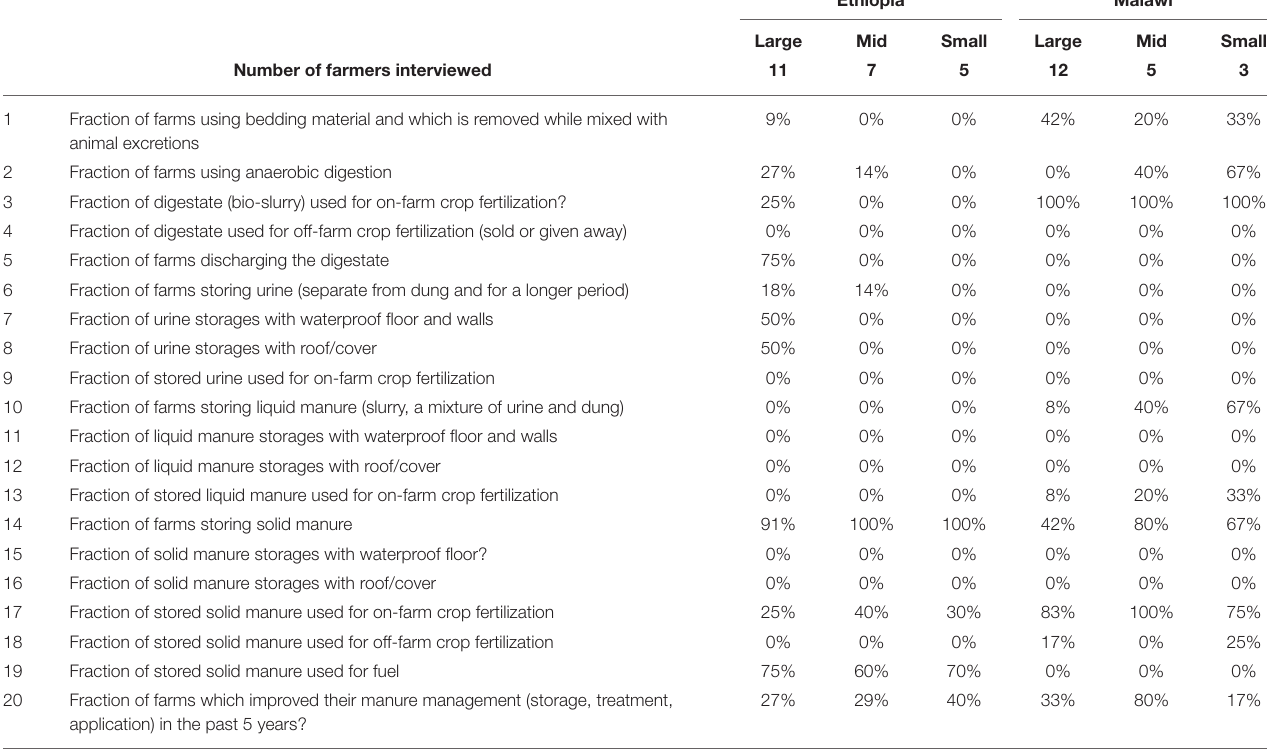
Ethiopia Malawi Large Mid Small Large Mid Small 9%